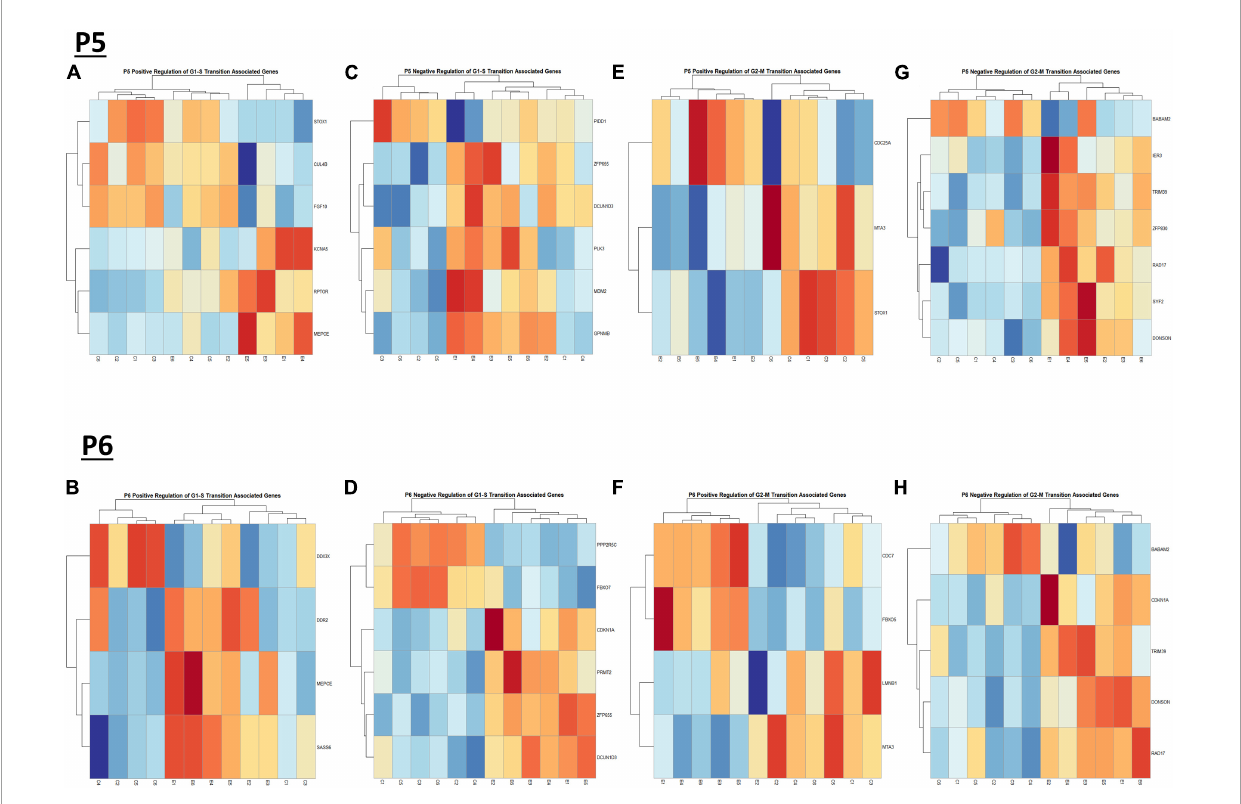
FIGURE9 Heatmap and hierarchical clustering of cell cyle associated genes at P5 and P6. R statistical software was utilized to construct heatmaps and hierarchical clustering dendrogram of relative gene expression across samples for significantly altered (adj. p < 0.05) and categorized cell cycle associated genes as detailed in Methods. Positive regulation of G1-S transition associated gene expression is depicted in panel (A) for P5 and panel (B) for P6. Negative regulation of G1-S transition associated gene expression is depicted in panel (C) for P5 and (D) for P6. Positive regulation of G2-M transition associated gene expression is depicted in panel (E) for P5 and (F) for P6. Negative regulation of G2-M transition associated genes is depicted in panel (G) for P5 and panel (H) for